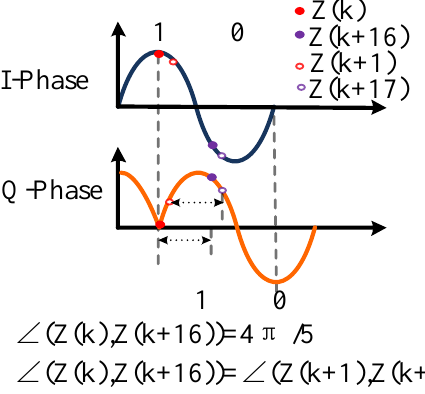
Figure 7. Analysis of (cid:93) ( Z ( k ) , Z ( k + 16 )) : chips are different.